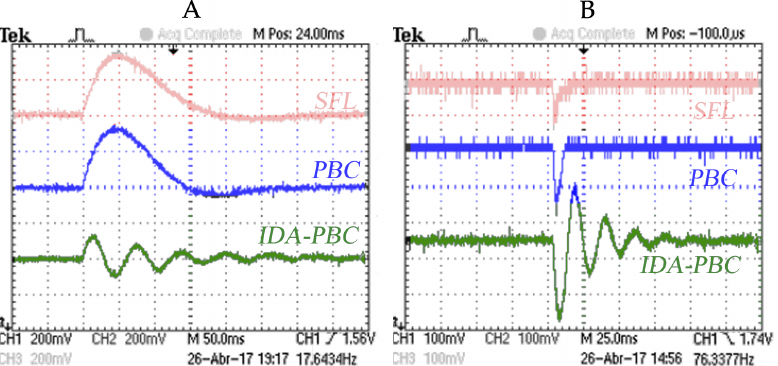
Figure 17. SHIL experimental result for Flyback ( A ) and Buck-boost ( B ) converters. Normalized output voltage x 2 for load perturbation (70–100%).